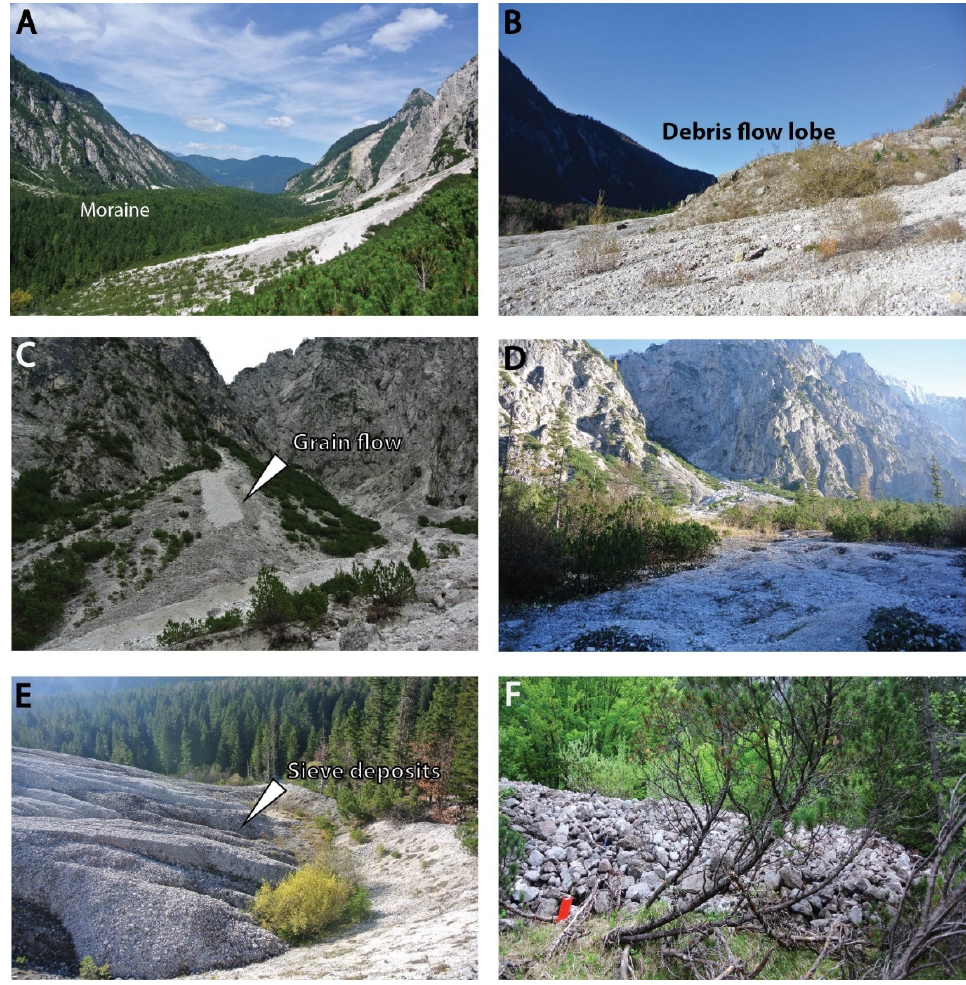
Figure 2. Examples of sedimentary bodies in Planica Valley. ( A ) Large Pleistocene moraine in the valley floor forming a 30 m high topographic ridge. ( B ) Debris flow lobe (approximately 5 m high). ( C ) Small grain flow deposited onto a scree deposit. ( D ) Out-of-channel (sheetflood) deposit in the distal parts of an alluvial fan. ( E ) Sieve deposits (dimension: 10 by 5 m and a height of half a meter. ( F ) A sedimentary deposit (note red A4 sized map to the left corner) with a similar sedimentary texture to sieve deposits (approx. three meters high) defined as “mega sieve deposits” in this study.